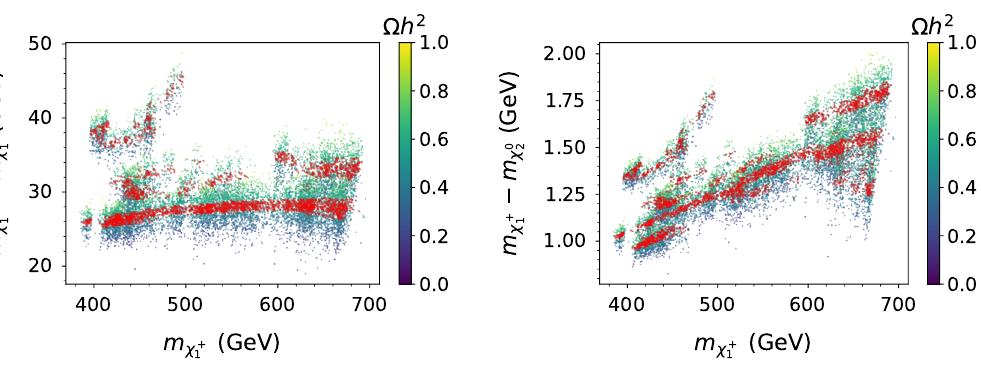
Figure 13 . Mass differences between the lightest neutralino (left) as well as the second-lightest neutralino (right) and the lightest neutralino displayed against the lightest chargino mass. Corre- lations between the masses are displayed with the colour indicating the relic density. In addition, red dots correspond to a relic density of Ω h 2 = 0 . 120 ± 0 . 006 . The relic density is controlled by co-annihilation channels whose strength are dictated by the mass gap between the relevant